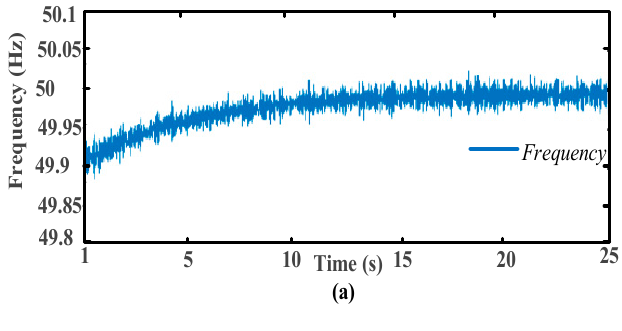
Figure 18. Frequency regulation.